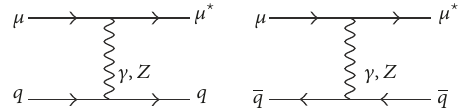
Figure 2: Leading-order Feynman diagrams for the 𝜇 ⋆ production at 𝜇𝑝 collider.